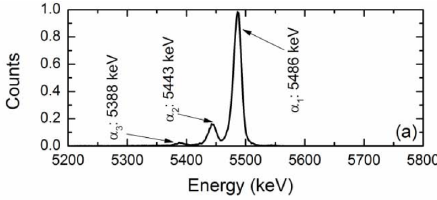
Figure 9. A pulse-height spectrum obtained for a 20 µ m n-type 4H-SiC (n-S20) SBD and 241 Am alpha source.